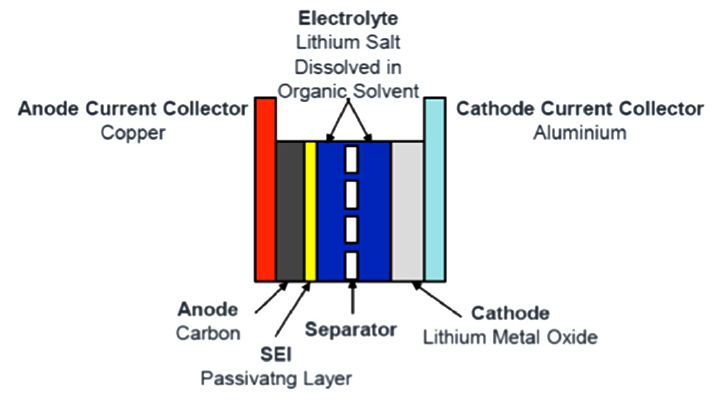
Figure 3. Formation of SEI layer